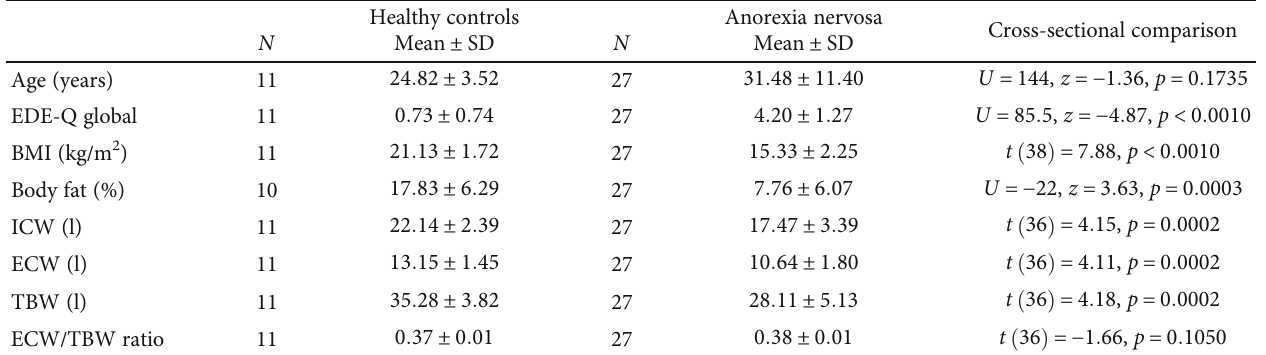
Table 1: Demographic, anthropometric, and clinical characteristics for AN participants and HCs.